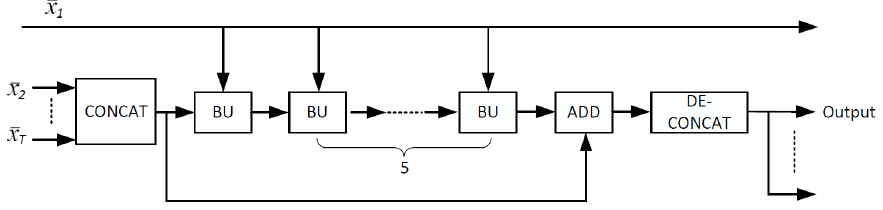
Figure 4. Temporal DCNN for joint reconstruction. Intermediate reconstructions x i = 1 ... T go through this temporal DCNN together to generate the final outputs.